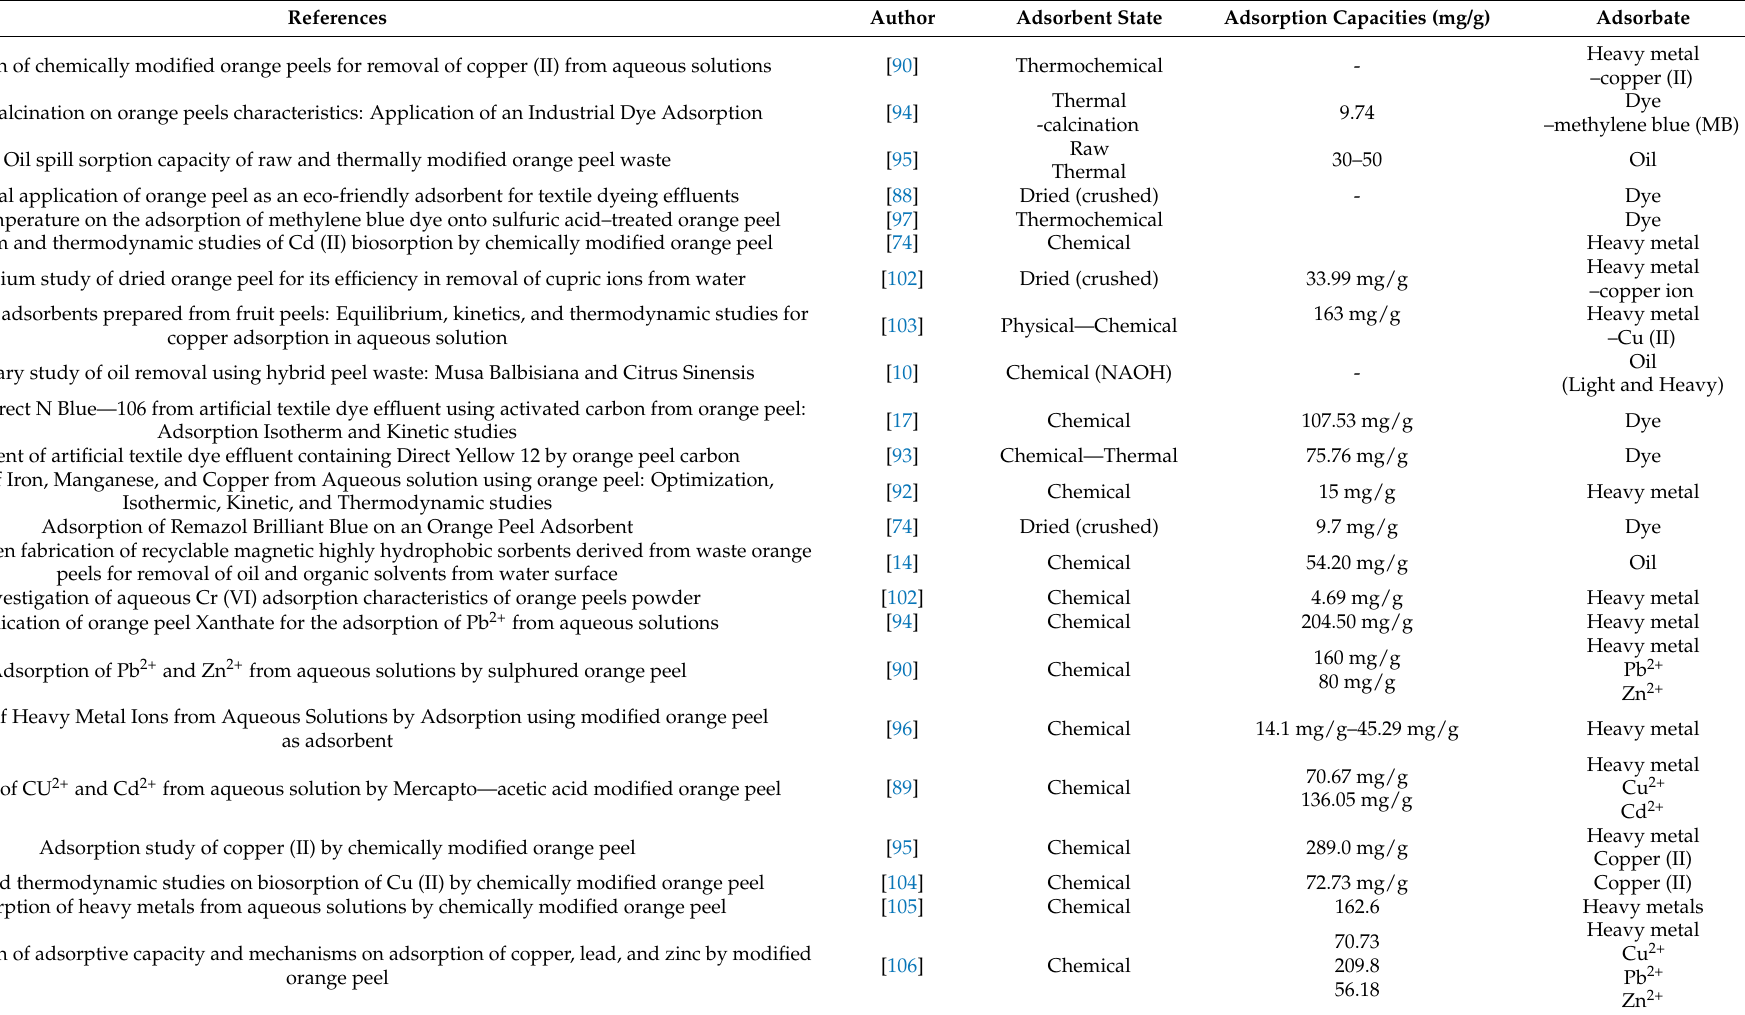
Table 4. Summary of adsorption studies with orange